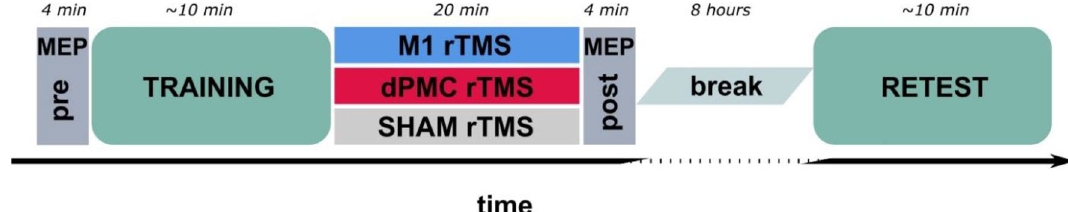
Figure 1. Experimental design. At the onset of the experiment, 20 motor evoked potentials (MEPs) of the right abductor pollicis brevis muscle (APB) were evoked at 0.1 Hz with the stimulator output set to an individually adjusted intensity to elicit MEPs of ~ 1 mV (MEPpre). This baseline assessment of corticospinal excitability (CSE) was followed by 14 blocks of task training with the right hand (TRAINING). Immediately after termination of TRAINING, participants received low-frequency (1 Hz) repetitive transcranial magnetic stimulation (rTMS) of either the left primary motor cortex (M1 rTMS), the dorsal premotor cortex (dPMC rTMS), or SHAM rTMS. 20 MEPs from the APB were again recorded (MEPpost) with the same individually adjusted stimulator output level as during the MEPpre assessment. Participants were retested on task performance (14 blocks) after an interval of 8 h